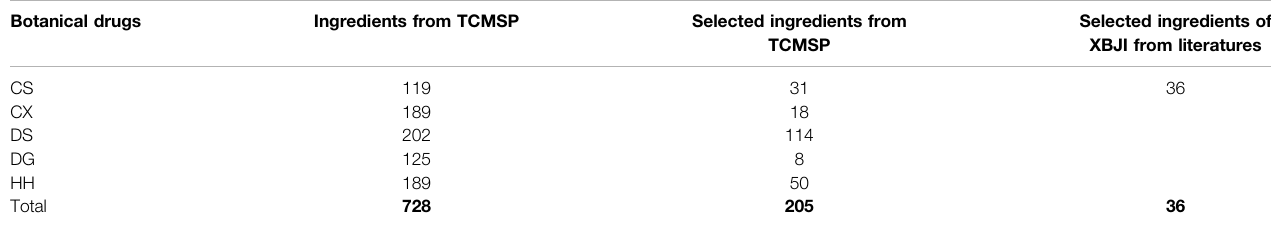
TABLE 2 | Statistics on the number of XBJI ingredients collected in the database and from literatures. Botanical